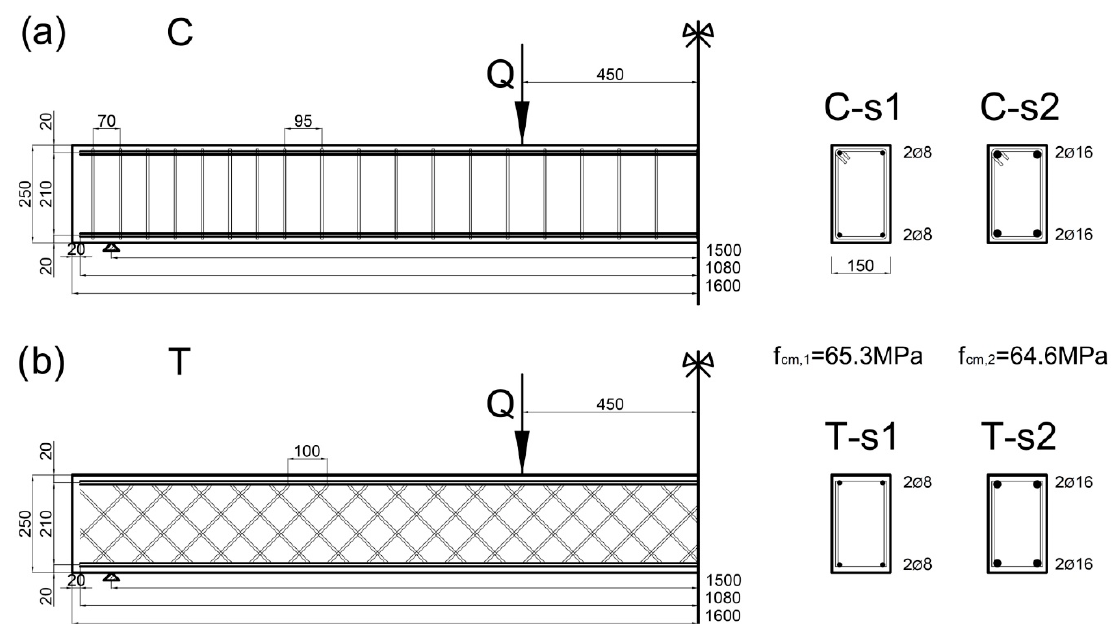
Figure 2. Schemes of beam reinforcement: ( a ) conventional layout of Series 1 C-s1 and Series 2 C-s2 , ( b ) truss-shaped layout of Series 1 T-s1 and Series 2 T-s2 .